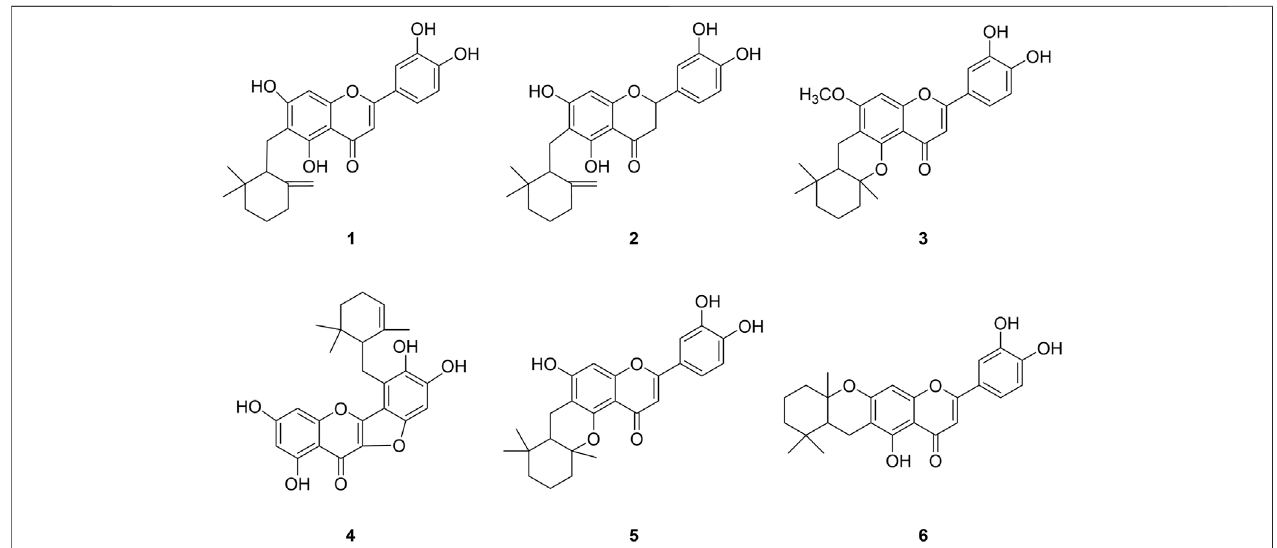
FIGURE 1 | Chemical structures of isolated bacterial neuraminidase inhibitors from Helminthostachys zeylanica (L.) Hook.